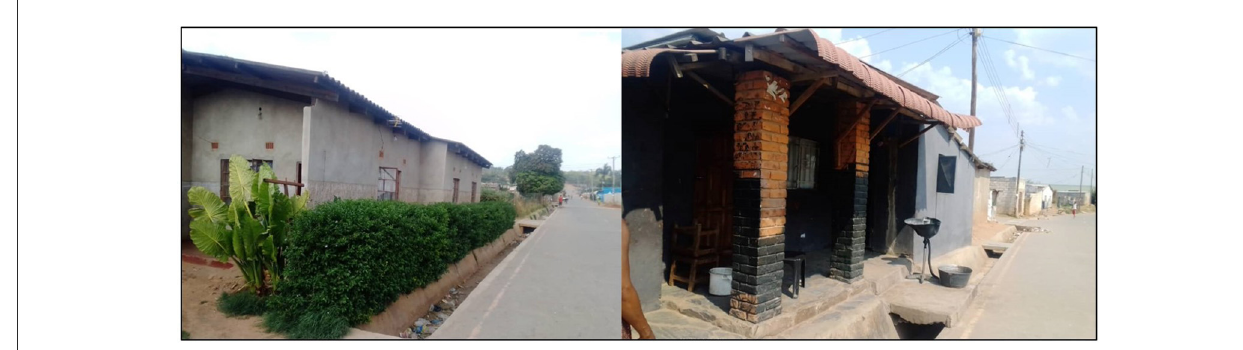
FIGURE10 Titled houses situated less than a meter from a public drainage channel and road, Bauleni